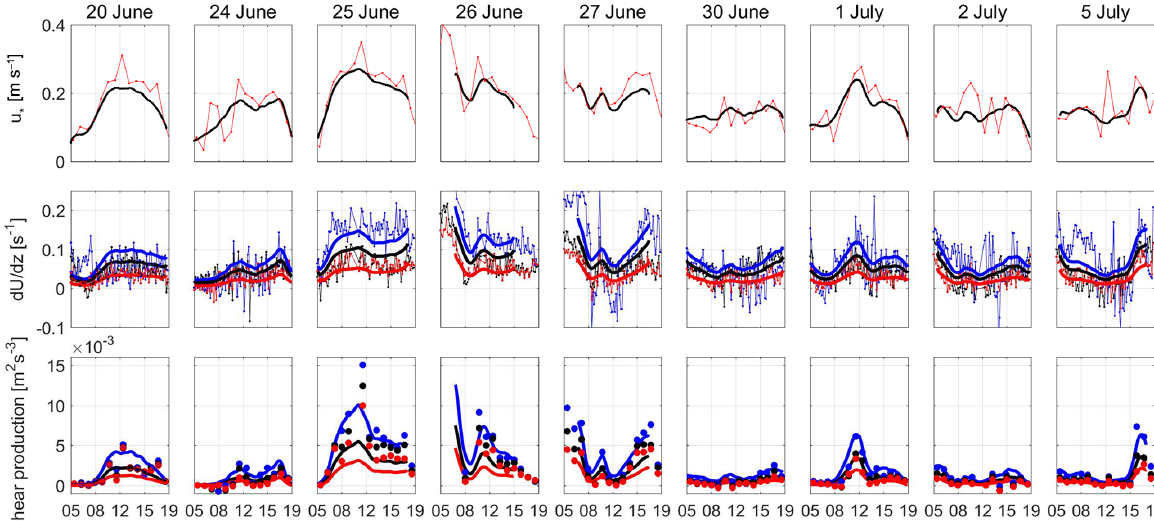
Figure 8. The upper row shows the modeled stability-corrected friction velocity (black line) and observations at 3.23m (red line with dots) for nine simulated days. The simulations are performed only for unstable conditions, whereas measurements are shown between 05:00 and 19:00UTC on all days. The middle row shows the measured wind gradient at 2.73, 4.23 and 6.75m as thin blue, black and red lines with dots, and the corresponding modeled wind gradients is shown as full blue, black and red lines for the 3, 4 and 7m model levels. The lower row shows the modeled shear production interpolated to the measurement heights of the three upper levels on the small tower as full lines. The corresponding hourly budget shear production values are shown as blue, black and red circles when available under the conditions discussed in Part